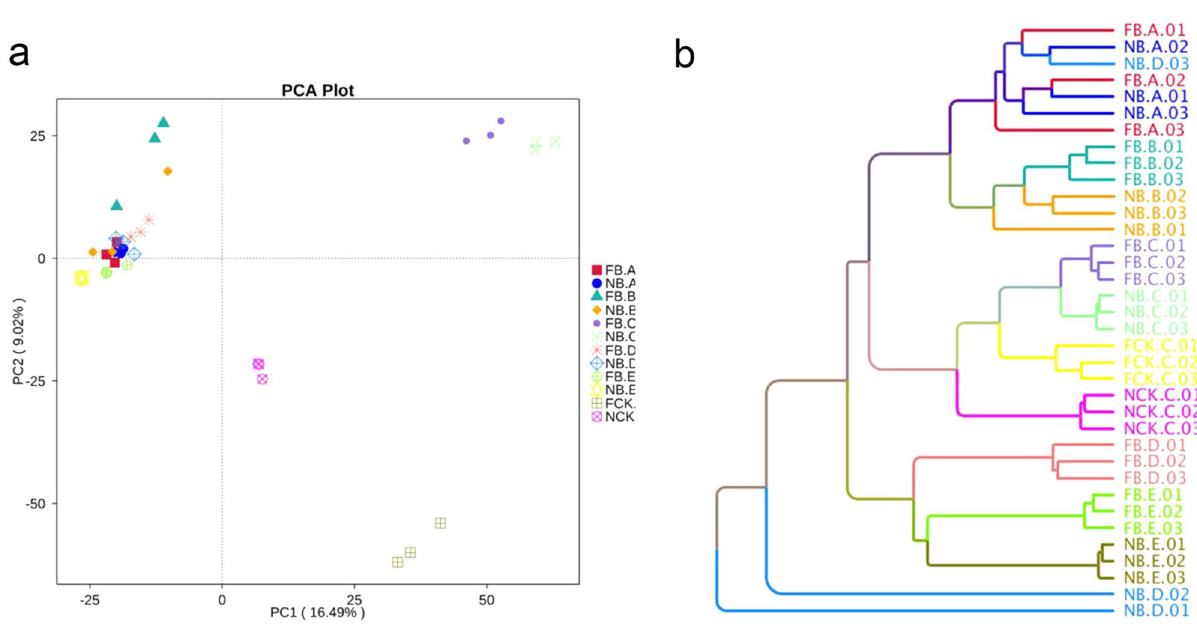
Figure 3. Plant compartment drives the composition of the bacterial communities at the OTU level. ( a ) Principle component analysis (PCA) of square-root transformed samples based on rarefaction to 2000 reads per sample. ( b ) Hierarchical clustering (group average linkage) of the samples based on Weighted Unifrac. PCA and hierarchical clusters were based on 3 biological replicates (rhizosphere soil and root, rhizome, leaf samples) and were constructed in PRIMER 7 with 10,000